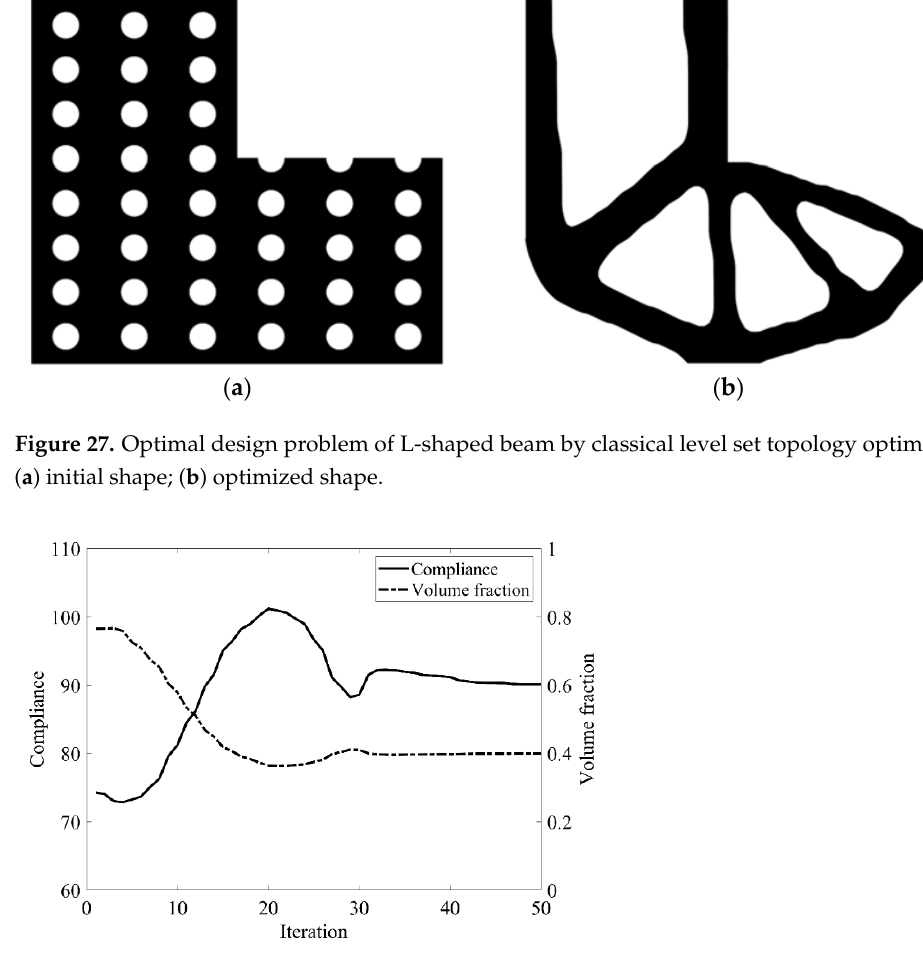
Figure 28. Convergence history of the compliance and the volume fraction for L-shaped beam by classical level set topology optimization.